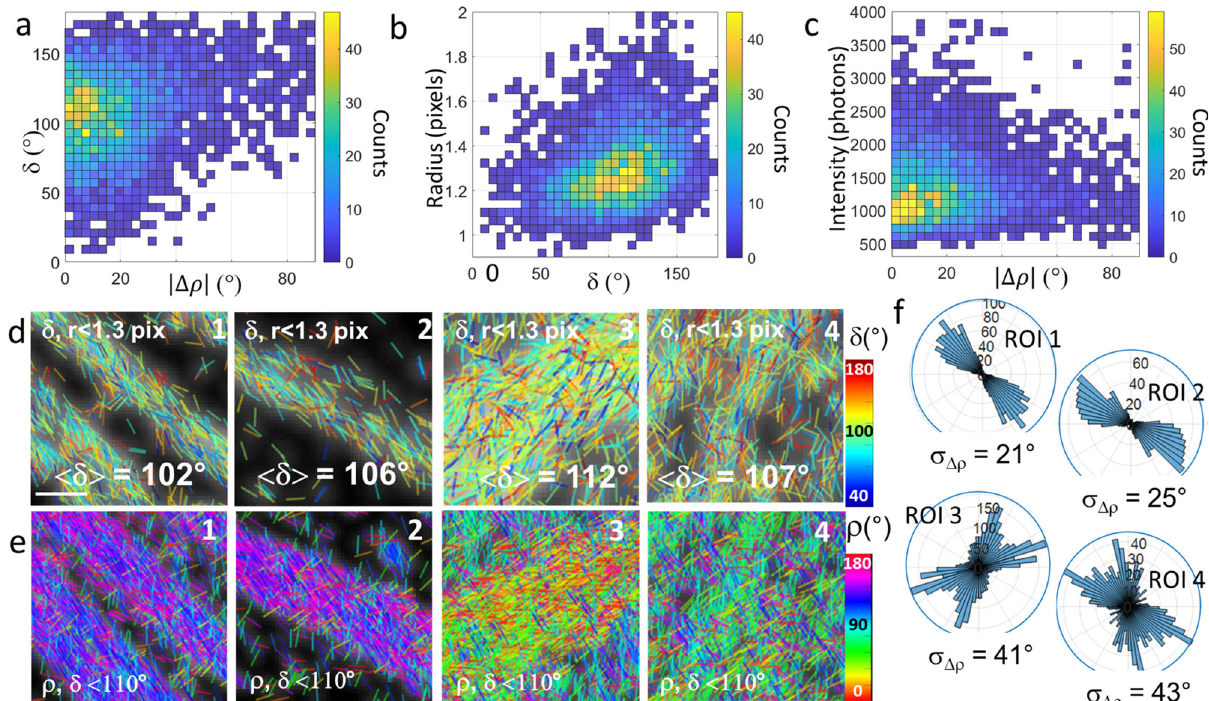
Fig. 3 In fl uence of the detection parameters on 4polar-STORM imaging. a 2D histogram of (| Δ ρ |, δ ) values obtained in single AF488 molecules (all (cid:4) (cid:5) detected intensities) present in ROI 1 (rectangle in Fig. 2e), with 4 ρ ¼ ρ (cid:2) ρ . b 2D histogram of (PSF radius, δ ) values of the same region. c 2D histogram of (intensity, | Δ ρ |) values of the same region. d Same 4polar-STORM images as in Fig. 2e, f, depicting δ sticks only for molecules for which r < 1.3 pixels (169 nm). The corresponding average < δ > over all measured molecules (present in the rectangle for ROIs 1 – 3 or the whole region for ROI 4 as in Fig. 2e) are shown. 4polar-STORM analyses were repeated independently on SF ROIs of three different samples (about 3 – 5 cells per sample) with similar results. e Same ROIs as in ( d ) showing ρ stick images only for molecules with δ < 110° (all PSF radii). f Corresponding polar-plot histograms of ρ for regions indicated in ( e ). The corresponding σ Δρ values are shown. Scale bar ( d , e ), 800 nm. Source data are provided as a Source Data fi